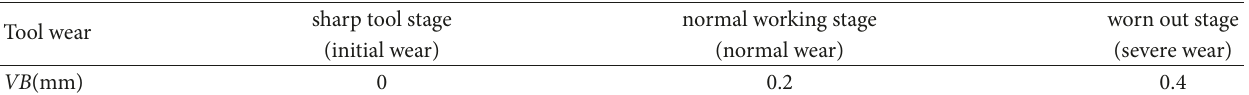
Table 3: The stages of tool